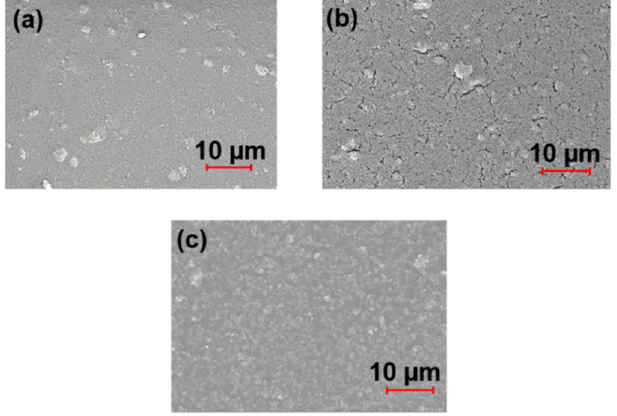
Figure 4. SEM images of ( a ) pure TiO 2 , ( b ) TiO 2 ̶ KH550 undoped with PEG, and ( c ) TiO 2 ̶ KH550 ̶ PEG films.